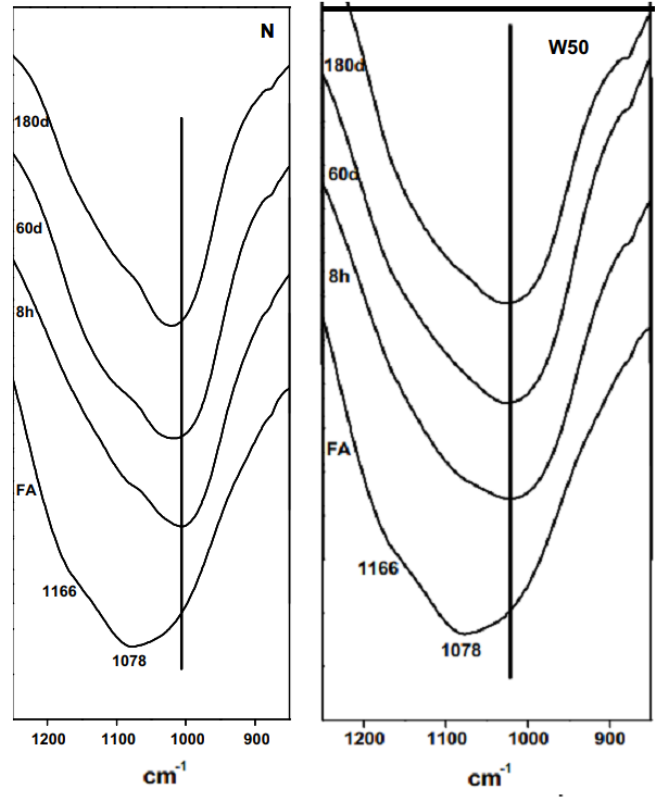
Figure 7. Si-O-T asymmetric vibration band with silica modulus, N-NaOH activator, and both (NaOH+Na 2 SiO 3 ) in W50 such that Na 2 O/SiO 2 = 0.69 (From Elsevier Ref. [79] and used with copyright permission).